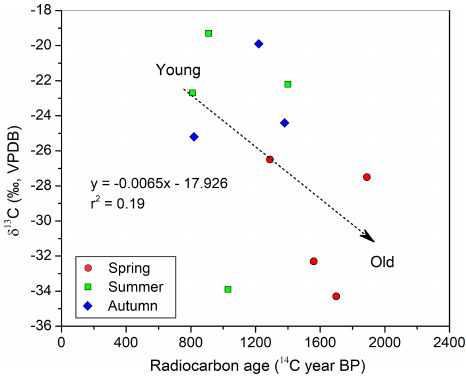
Figure 9. Relationship between δ 13 C and radiocarbon age of the emitted CO 2 from the Wuding River